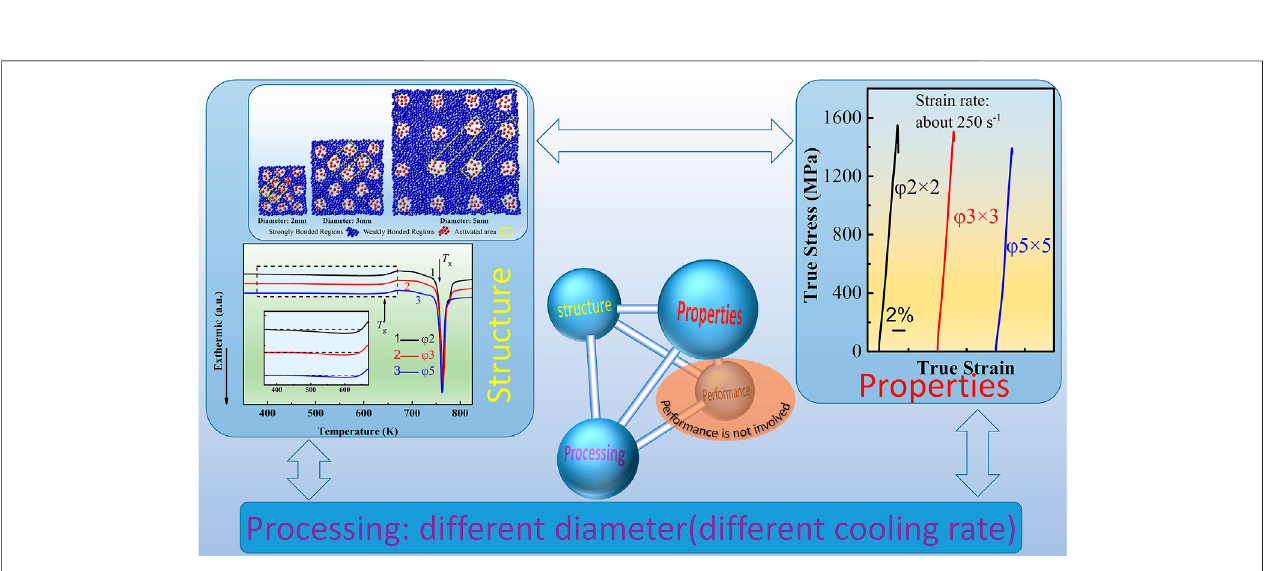
FIGURE 6 | The relationship among processing, structure and properties is re fl ected in the dynamic compression of Zr 65 Cu 18 Ni 7 Al 10 BMGs with different diameters.